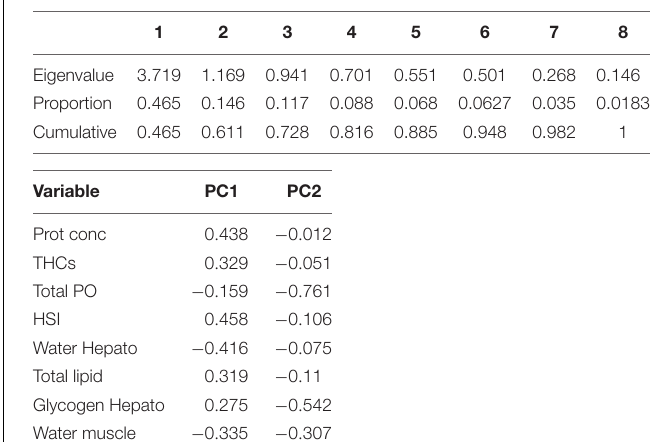
TABLE 6 | PCA Eigen values and loadings for the different variables in PC1 and PC2.